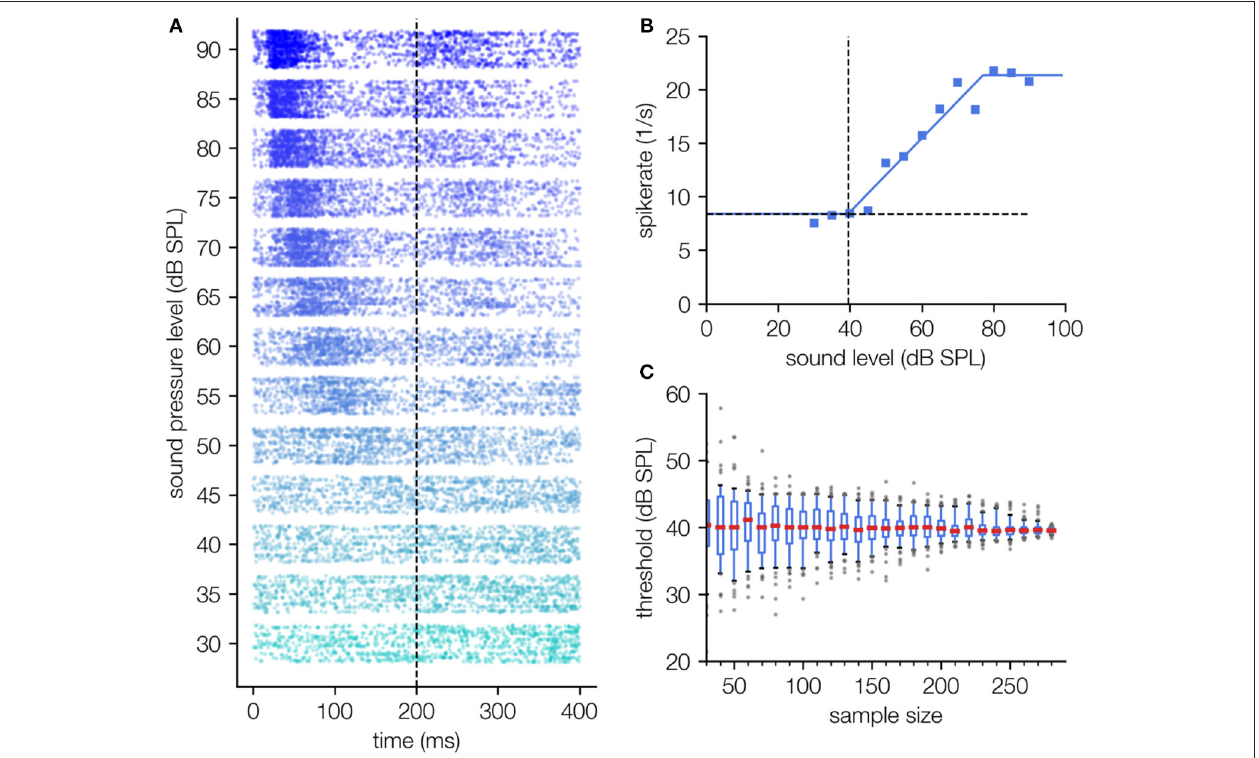
FIGURE 6 | Threshold determination using single unit spiking data recorded in the auditory cortex. (A) Dot raster diagram of the measured spikes (timestamps of spikes) for different stimulus intensities of a 2kHz pure tone (30–90 dB SPL, onset 0ms, offset 200ms) and 300 measurement repetitions. The typical latency shift as a function of the applied sound pressure level can be observed. (B) Hard sigmoid fit; For this fitting procedure the function f 0 ( x ) σ 2 . This difference arises from the fact that spontaneous spike rate and evoked spike rate can simply be added. Thus, f 0 ( x ) 2 recordings where the fit function is + q the hard sigmoid added by the spontaneous activity term are a good description of the level response characteristics (B) . (C) The determined threshold shows no systematic dependency on the number of measurement